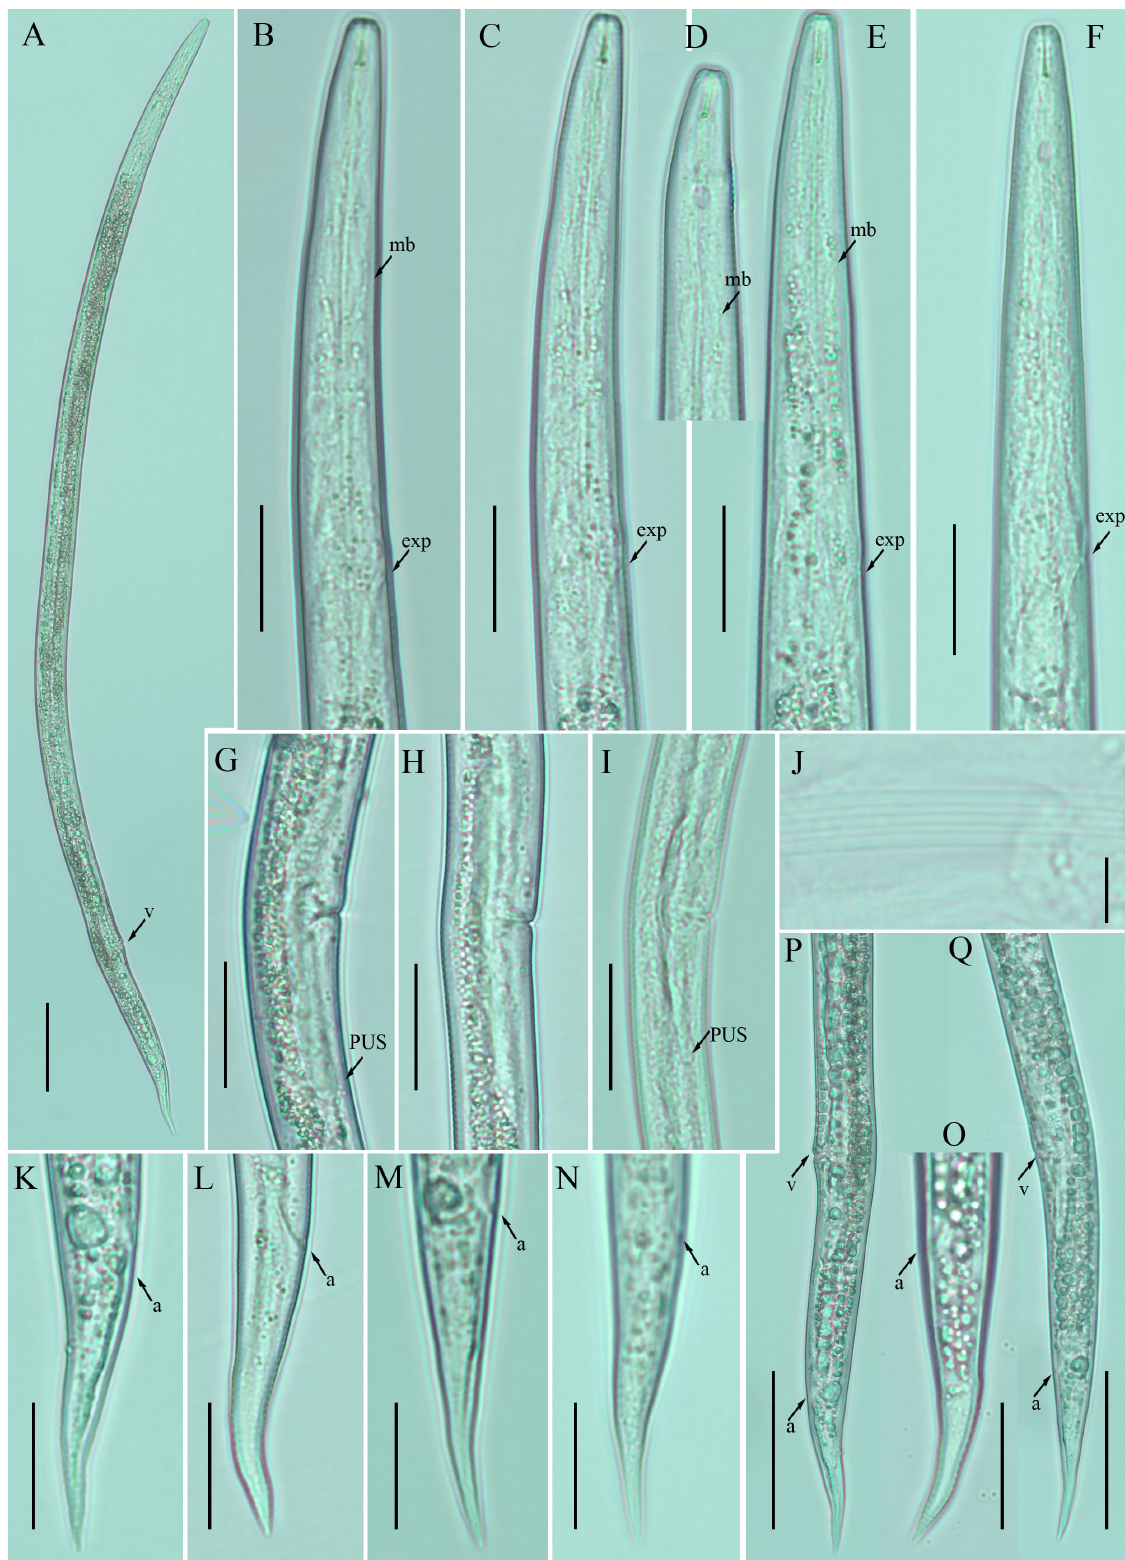
Figure 1. Photomicrographs of female Ditylenchus anchilisposomus (Tarjan) Fortuner [28,40] ( A ) Entire body; ( B – F ) pharyngeal regions; ( G – I ) vulval regions; ( J ) lateral field lines; ( K – O ) tail regions; ( P , Q ) posterior body to tail terminus. Scale bars: ( A , P , Q ) 50 µm; ( B – I , K – O ) 20 µm; ( J ) 5 µm. Arrows: (a) anus; (exp) secretory–excretory pore; (mb) median bulb; (PUS) postvulval uterine sac; (v) vulva.